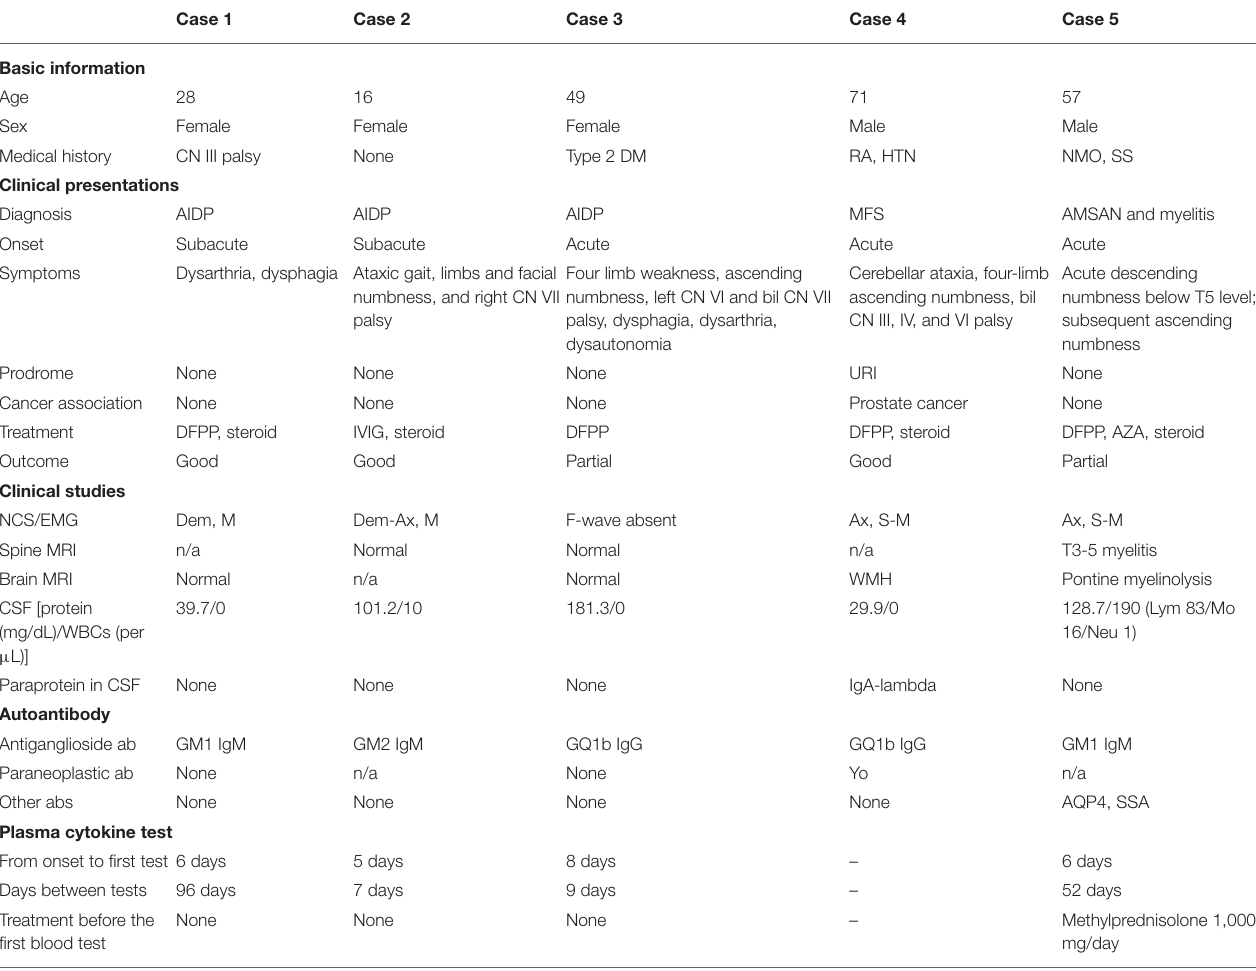
TABLE 1 | Clinical and laboratory studies of the enrolled